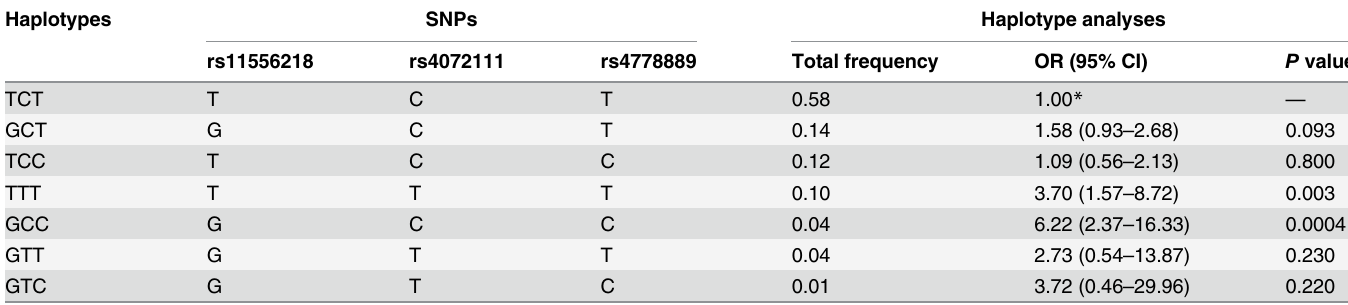
Table 4. Haplotype analysis between the case and control